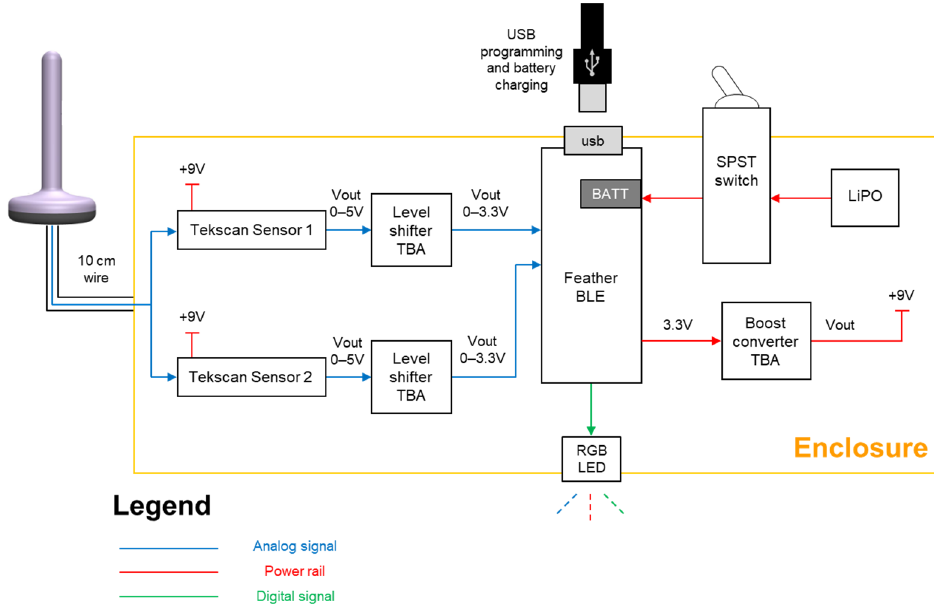
Figure 4. Circuit diagram of the networking and battery module.